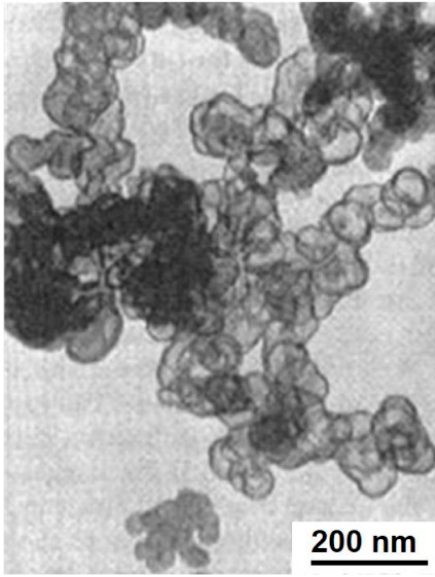
Figure 4. TEM image of hollow particles of carbon black after thermal oxidation. Reproduced with permission from Reference [39] Copyright Marcel Dekker, 1993.